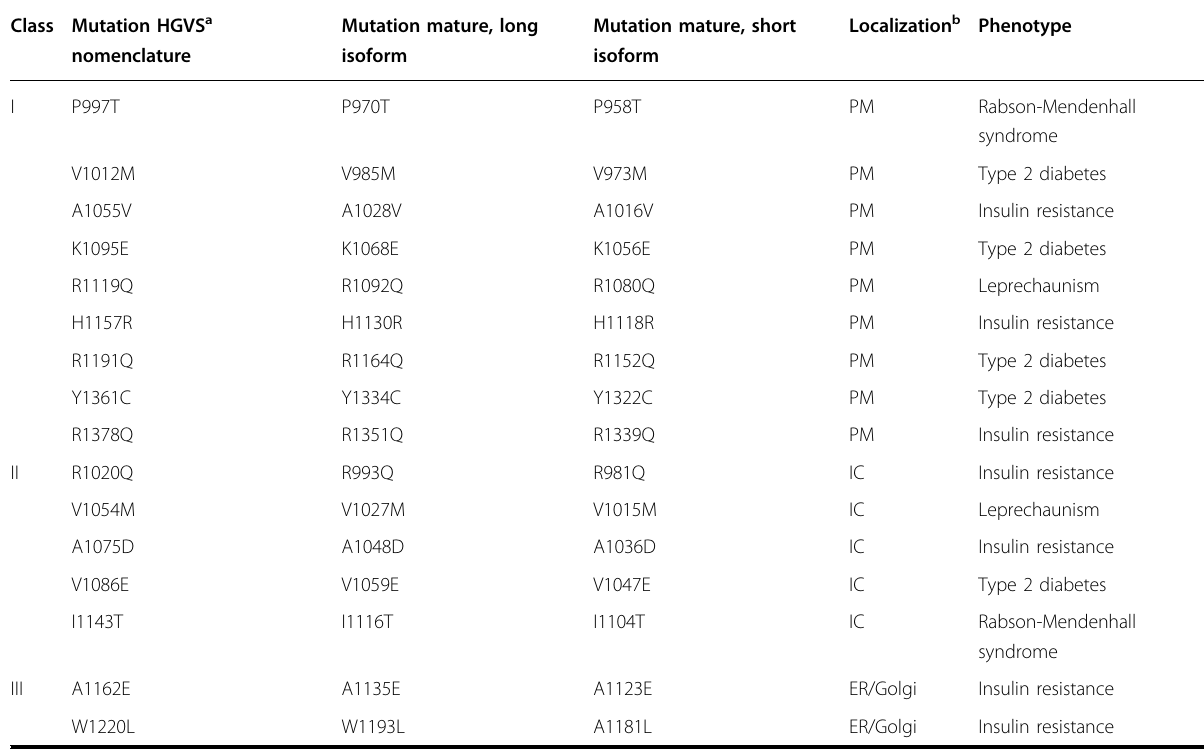
Table 2 Characterization of IR mutations found in human